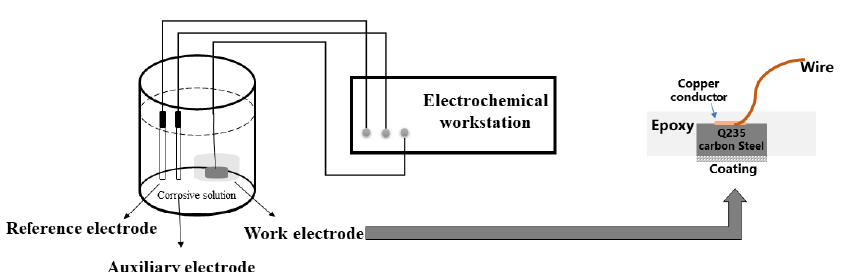
Figure 2. The coating’s sample diag ram.